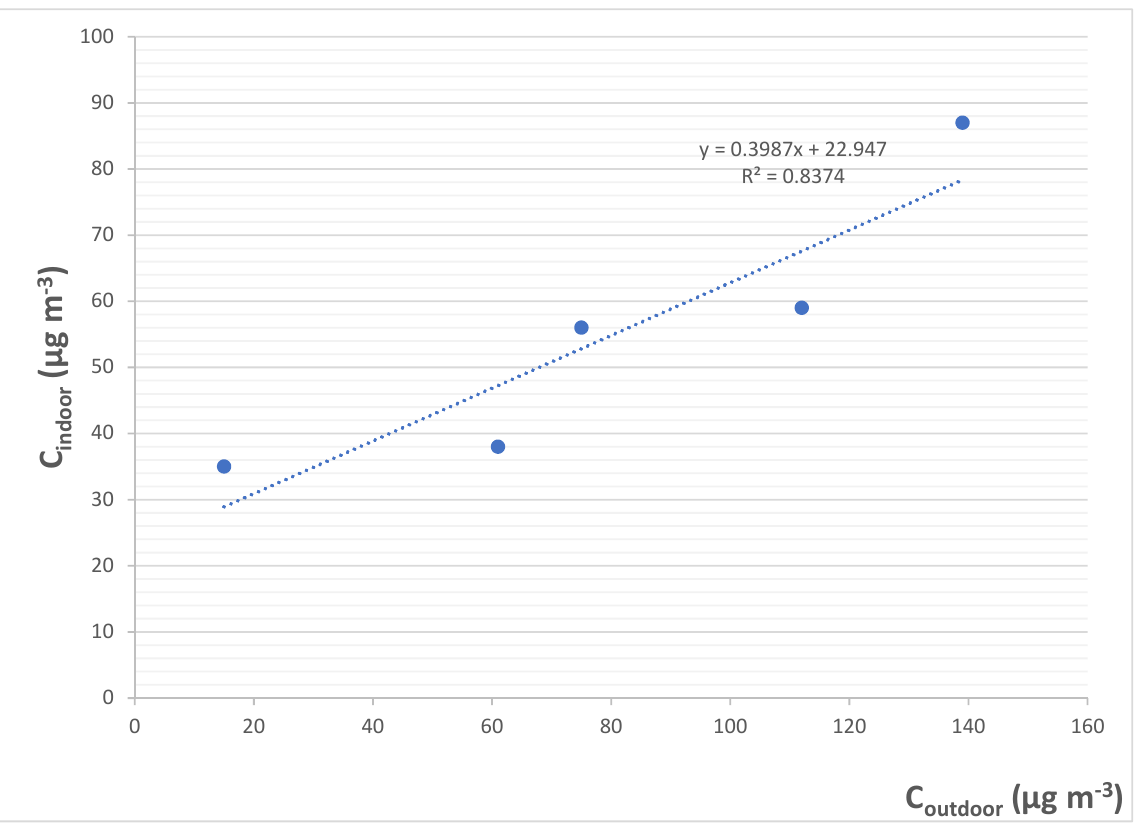
Figure 3. Relationships between the concentration of PM 4 outdoors and indoors in the apartments without ETS in Katowice.